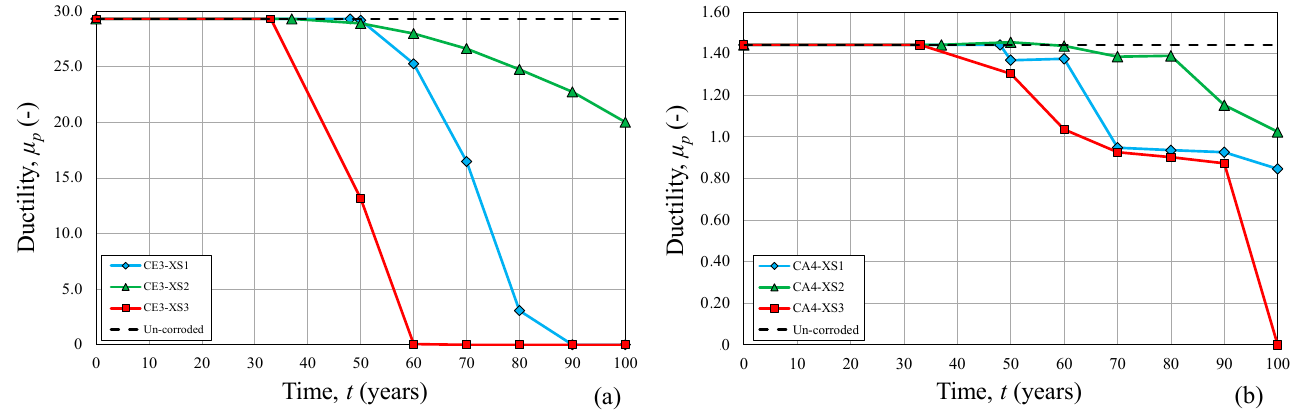
Figure 8. Evaluation of the ductility, µ p , reduction over time for different exposure classes: ( a ) panel CE3, and ( b ) panel CA4.